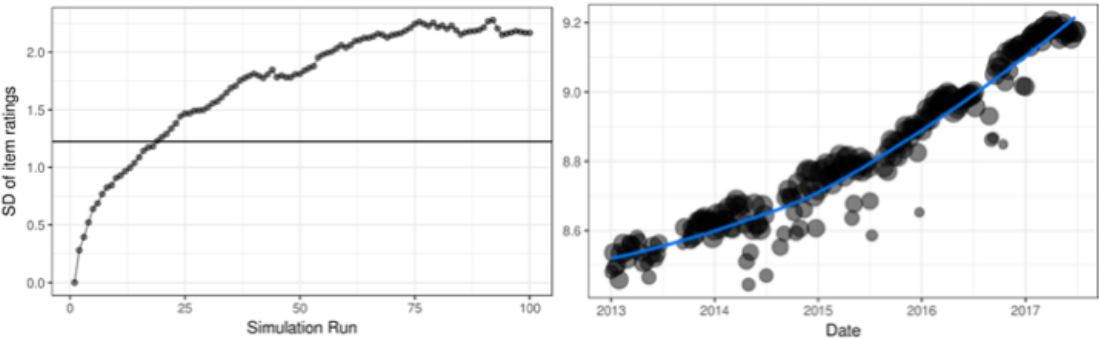
Figure 2. Rating variance inflation in a simulated ( left ) and real data example ( right ) using the Elo Rating System